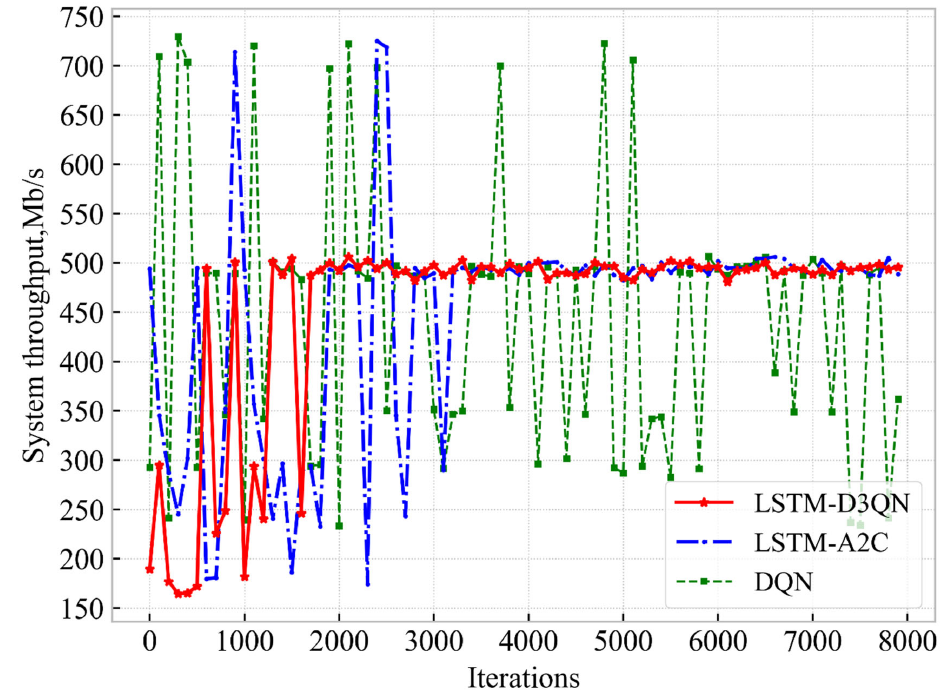
Figure 5. The comparison of system throughput for different methods.